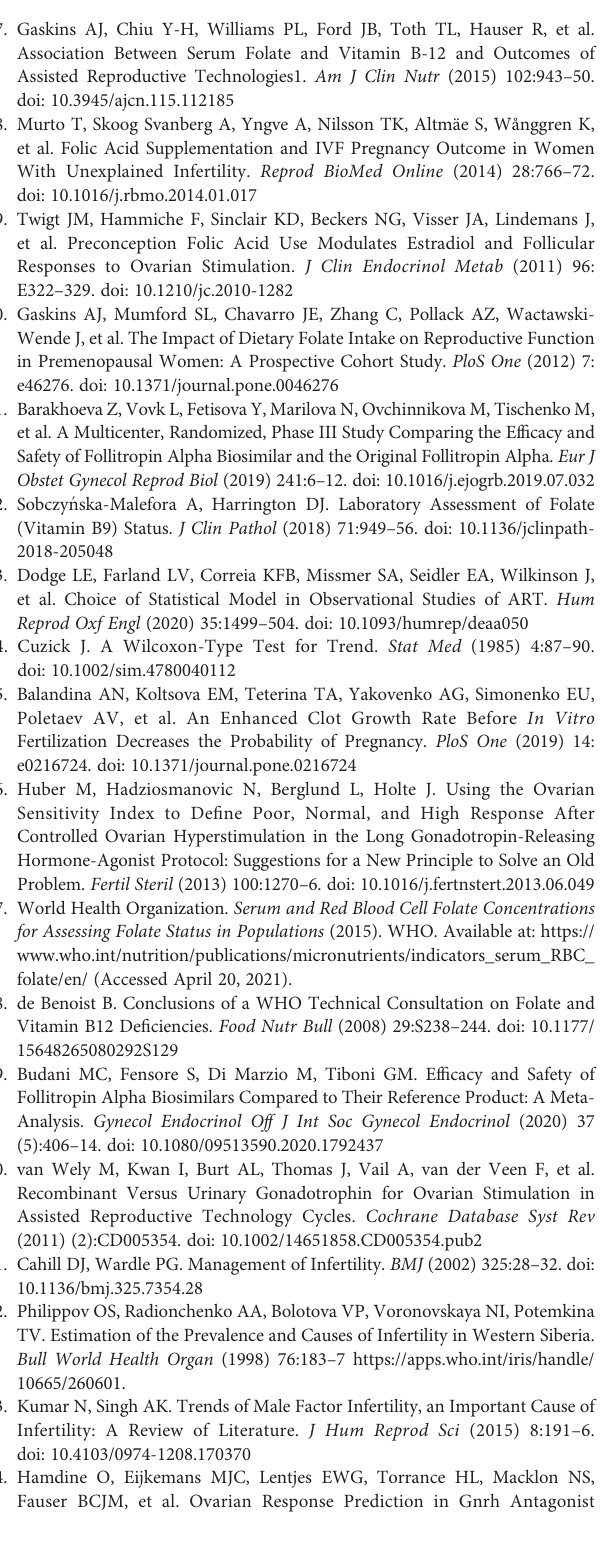
Supplementary Figure 1 | Adjustedmeanoocytecountsbythequartilesofthe serum Ca/Mg ratio. (A) Totaloocytesyield,adjustmentfor IVF/ICSIattempts(0;1) and continuousBMI,baselineserumAMHandAPTT,durationofstimulationanddoseofFSH.